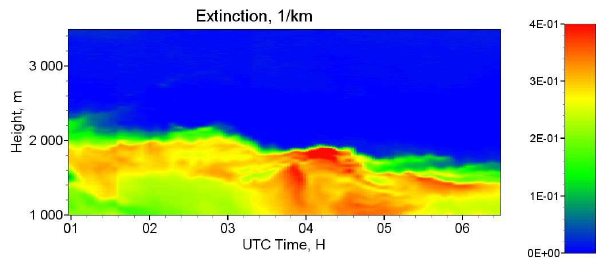
Fig. 7. Aerosol extinction at 355nm on the night of 21–22 July calculated using the Klett method. The assumed lidar ratio is 70sr. Fig.7. Aerosol extinction at 355 nm on the night of 21-22 July calculated using the Klett method.